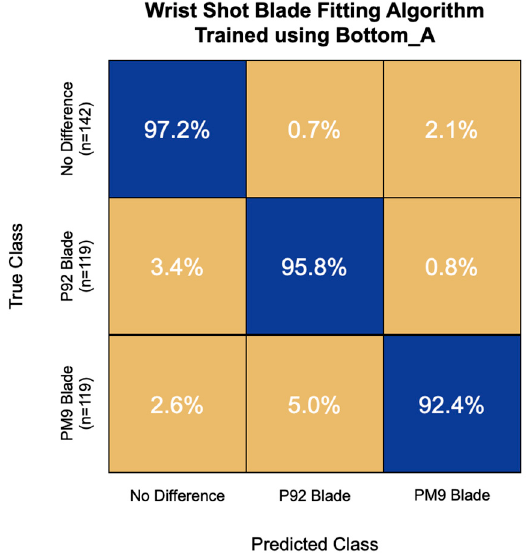
Figure 10. Confusion matrix of the blade fitting algorithm for wrist shot speed trained using bottom hand linear acceleration (Bottom_A) signal features. Overall model accuracy was 95.3%.